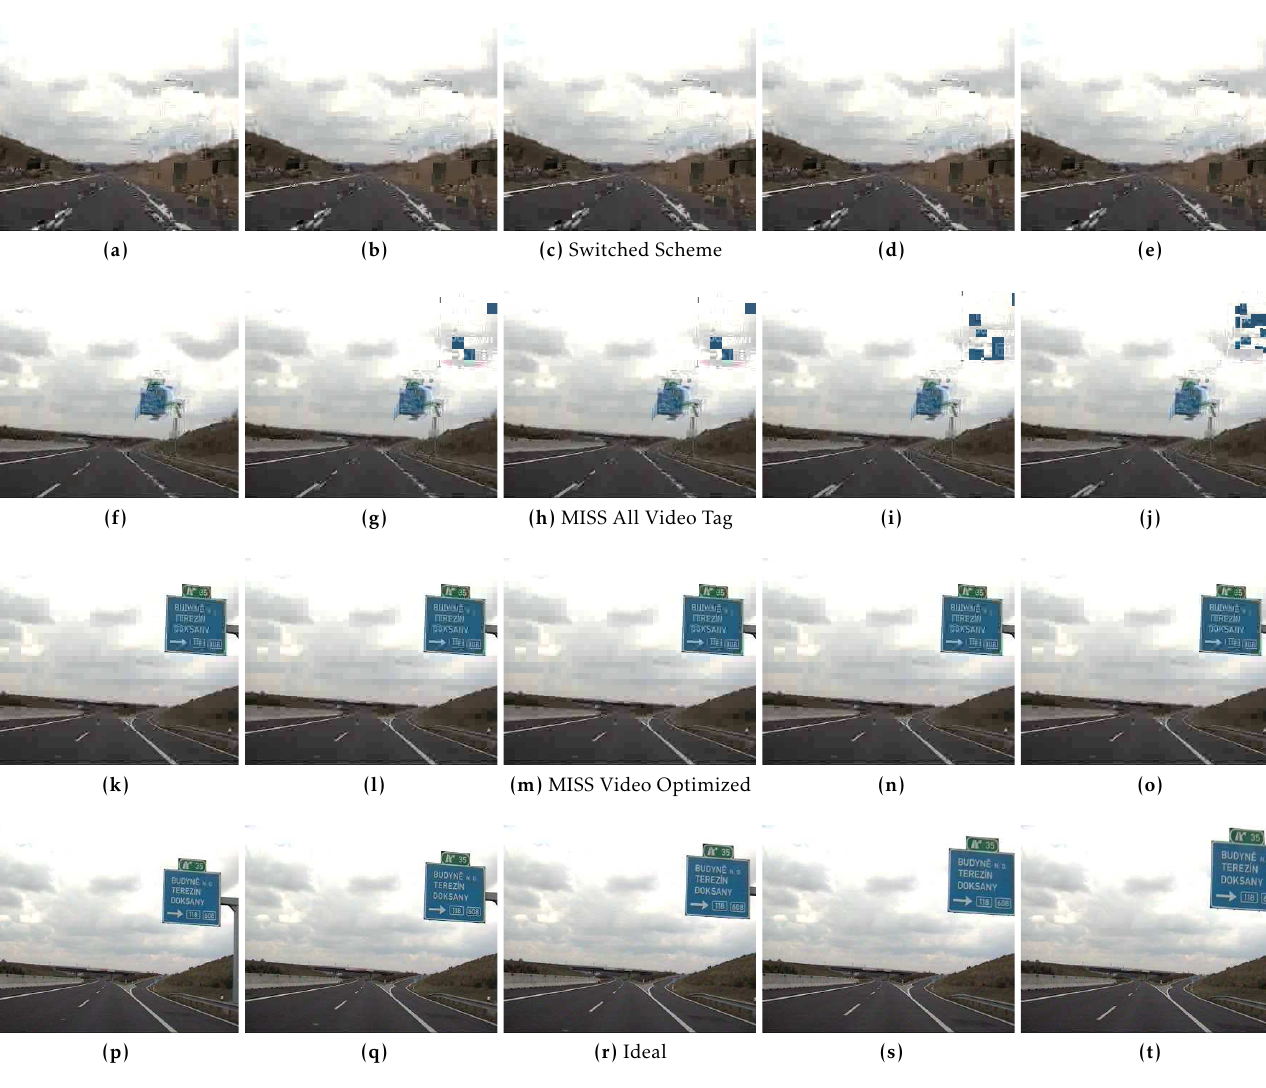
Figure 16. Visual Comparison of the reconstructed 1049-1053